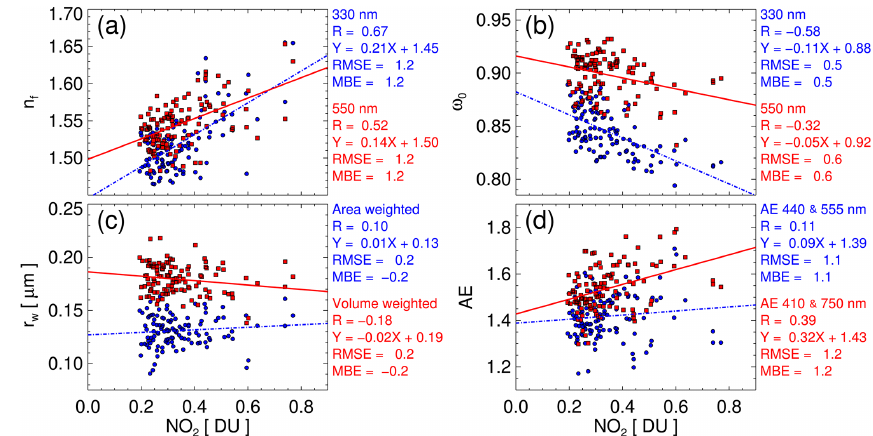
Figure 12. Comparison of the total column amount of NO 2 to the (a) real part of the refractive index of the fine mode ( n f ) and (b) aerosol single scattering albedo ( ω 0 ). The blue and red colors symbolize those retrieved at 330 and 550nm, respectively. Panels (c) and (d) compare the weighted mean radius ( r w ) and Ångström exponent (AE) to the total column NO 2 , respectively. The blue and red symbols in panel (c) represent the area- and volume-weighted mean radius, and those in panel (d) indicate different wavelength pairs for the AE calculations (blue at 440 and 555nm and red at 410 and 750nm).